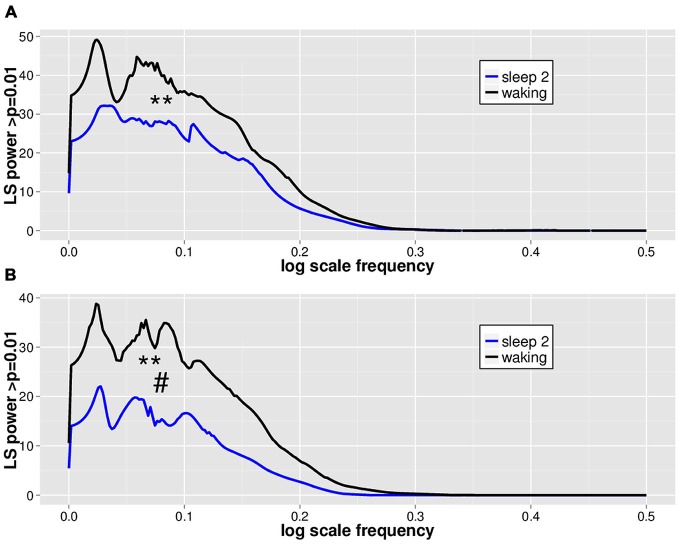
Mean significant Lomb-Scargle normalized periodogram areas from PDF plots of log scale frequencies for positive (A) and negative (B) LVDs. Data represent mean normalized Lomb-Scargle periodogram plots of power > p = 0.01 across 14 subjects for 8 min of EEG for waking (black) and sleep stage 2 (blue) LVDs. **p < 0.001 for mean number of significant peaks for waking vs. sleep 2 by linear mixed effect modeling. #p < 0.05 for total significant area for waking vs. sleep 2 by linear mixed effect modeling; see Table 2.